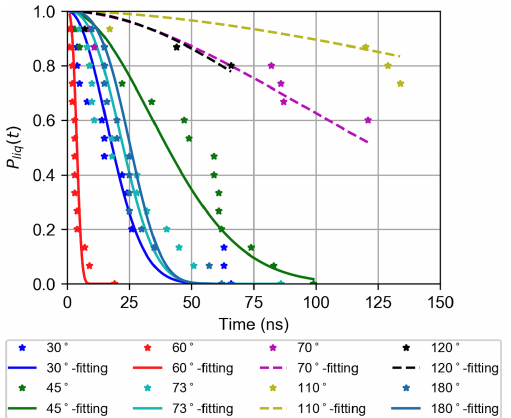
Figure 7. Probability for different wedge systems to remain in the liquid state as a function of time from 15 independent molecular dynamics simulations at T = 263K (stars), and fits to Eq. (1) (full and dashed